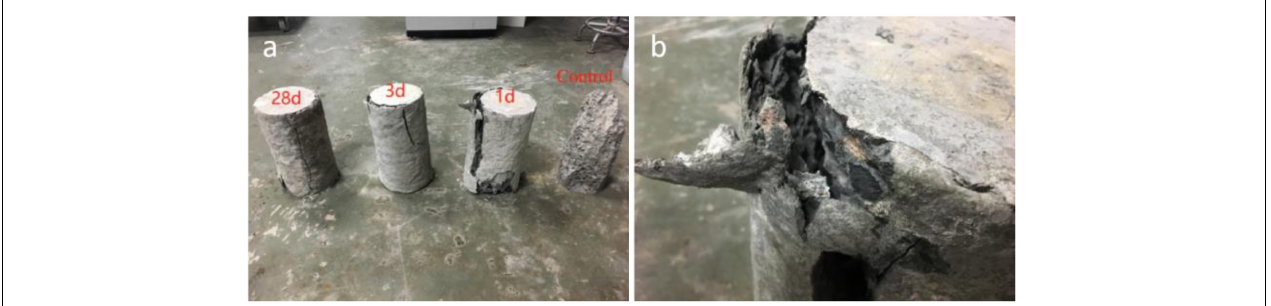
FIGURE 15 | Images showing (a) the damage pattern of concrete column (b) the fracture zone of the column.